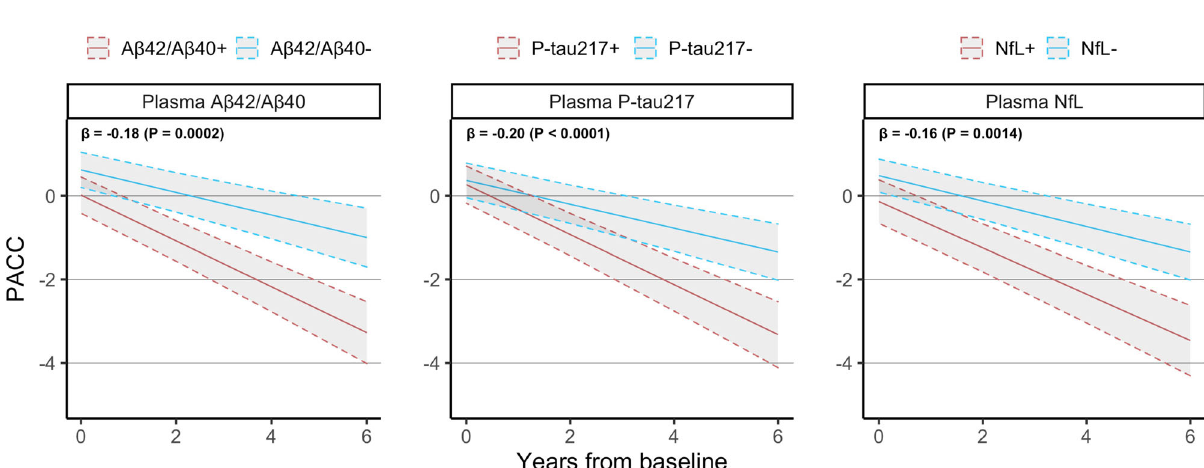
Fig. 1 Relationship between plasma biomarkers and change in PACC. This fi gure shows the longitudinal PACC trajectory expected for a biomarker- negative or biomarker-positive CU individual with average age, average education, and female sex. β -coef fi cients at the top left of each panel are presented in terms of “ points/year per standard deviation change in biomarker value ” and are derived from linear mixed effects models with longitudinal PACC as outcome and age, sex, education, plus each plasma biomarker included separately from each other as predictors. All statistical tests were two-sided with no adjustment for multiple comparisons. Shaded areas represent 95% con fi dence intervals of the regression